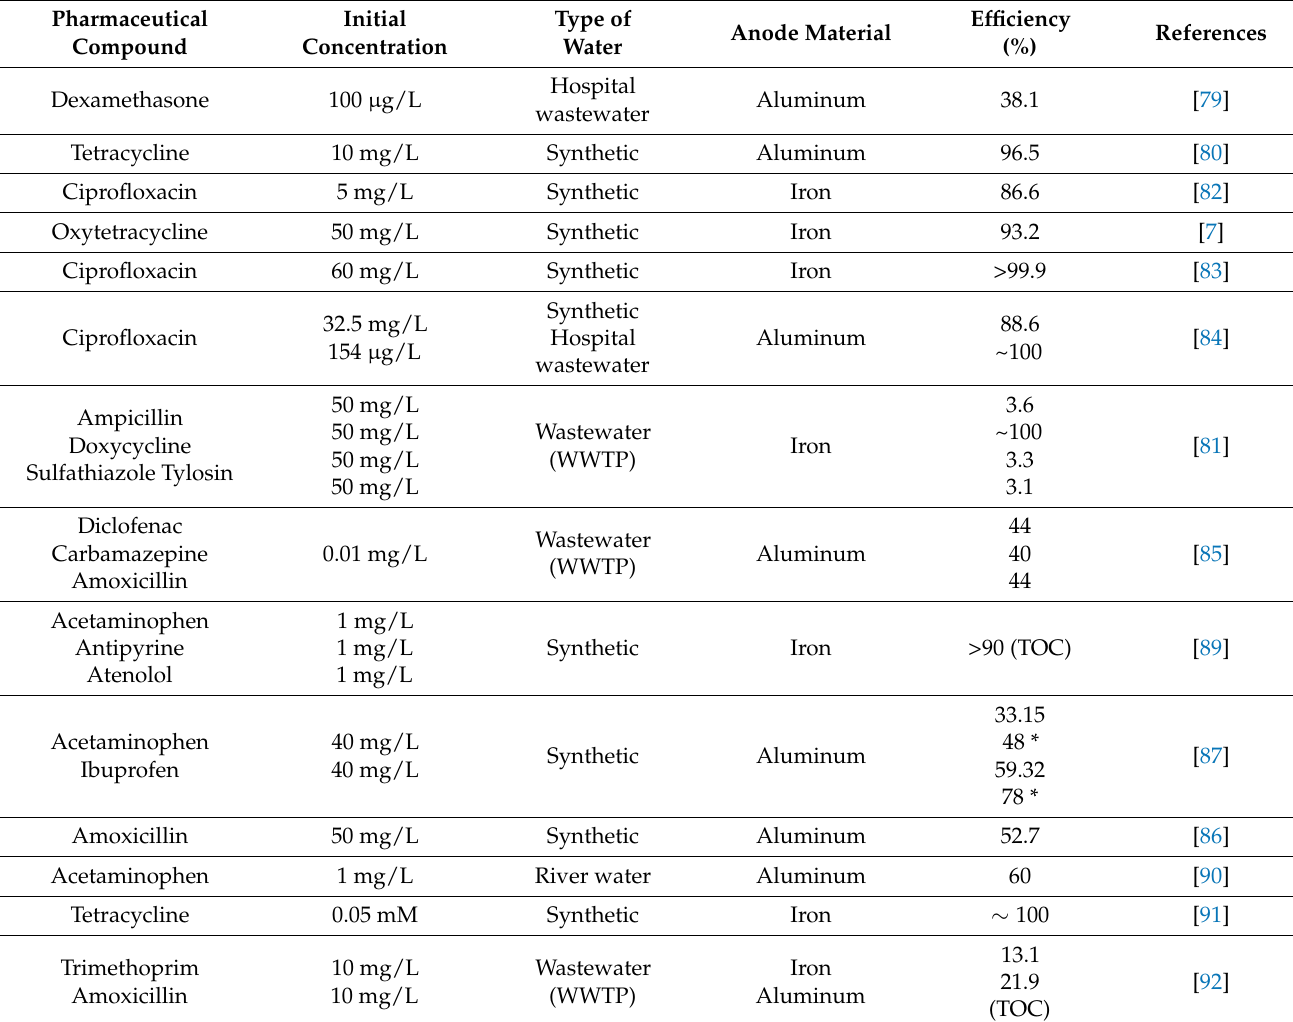
Table 2. Electrocoagulation processes for the removal of